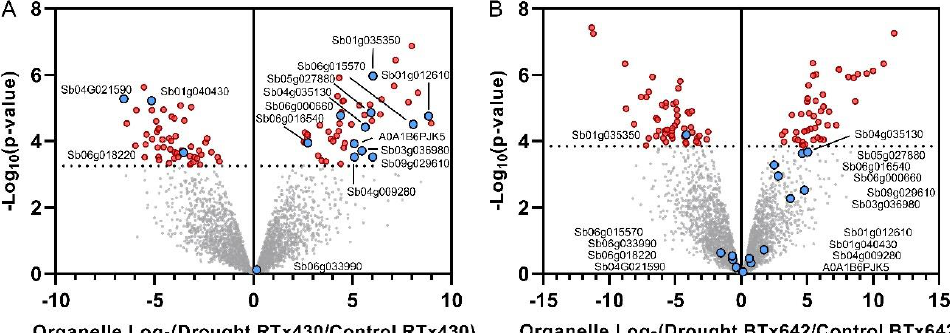
Figure 3. Comparison of genotype-specific drought responses in organelle-enriched samples of RTx430 ( A ) and BTx642 ( B ). Red datapoints passed a limma adjusted p -value threshold of 0.05. Pink